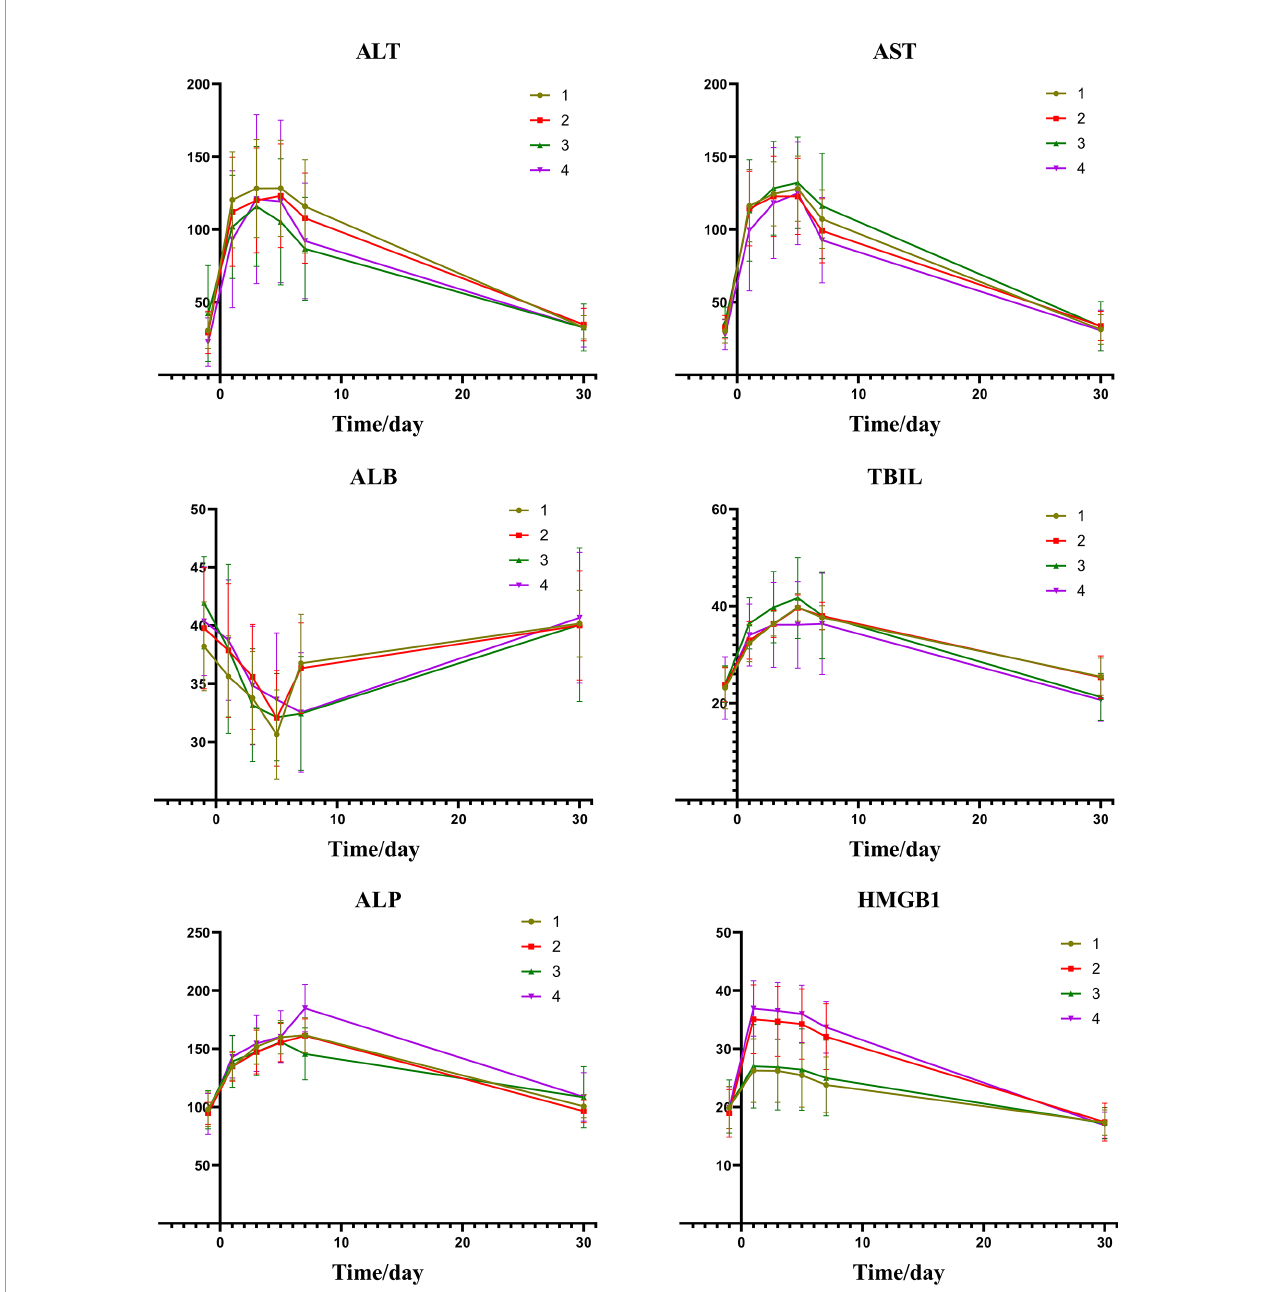
FIGURE 4 | Group1: low post-expression of HMGB1 with c-TACE; Group2: high post-expression of HMGB1 with c-TACE; Group3: low post-expression of HMGB1 with DEB-TACE; Group4: high post-expression of HMGB1 with